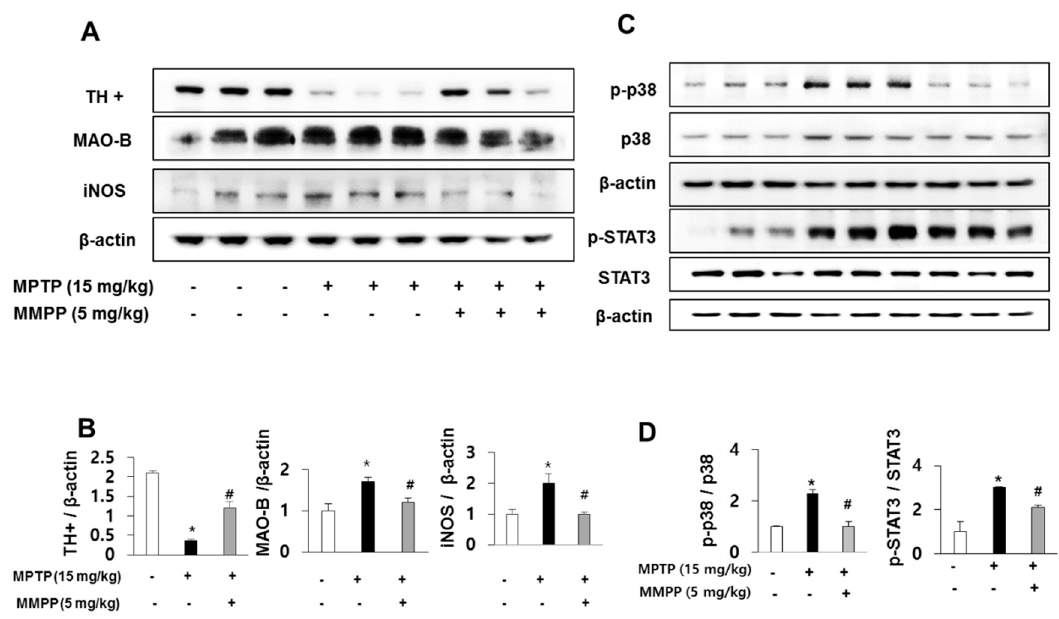
Figure 4. E ff ect of MMPP on MPTP-induced protein expressions. The e ff ects of MMPP on dopaminergic neuronal cell marker and inflammatory marker proteins were measured by western blotting. Expressions of TH + , MAO-B, and iNOS in the substantia nigra were measured ( A and B ). Expressions of p-p38 and p-STAT3 in the substantia nigra were measured ( C and D ). Values are presented as mean ± SD from 10 mice. * p < 0.05, significant di ff erence from saline-injected mice; # p < 0.05, significant di ff erence between MPTP-injected groups.